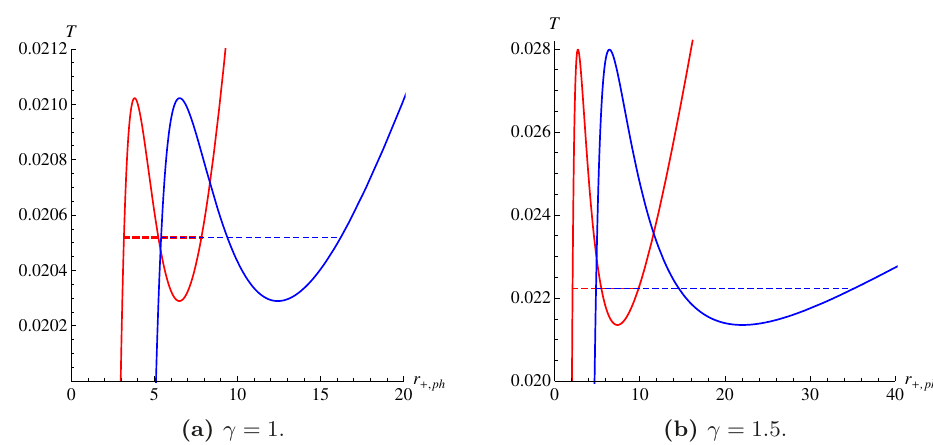
Figure 6. The parameters set to q = 1 . 9 and P = P c with the event horizon radius coordinate, and the blue lines are the curves with the photon sphere radius